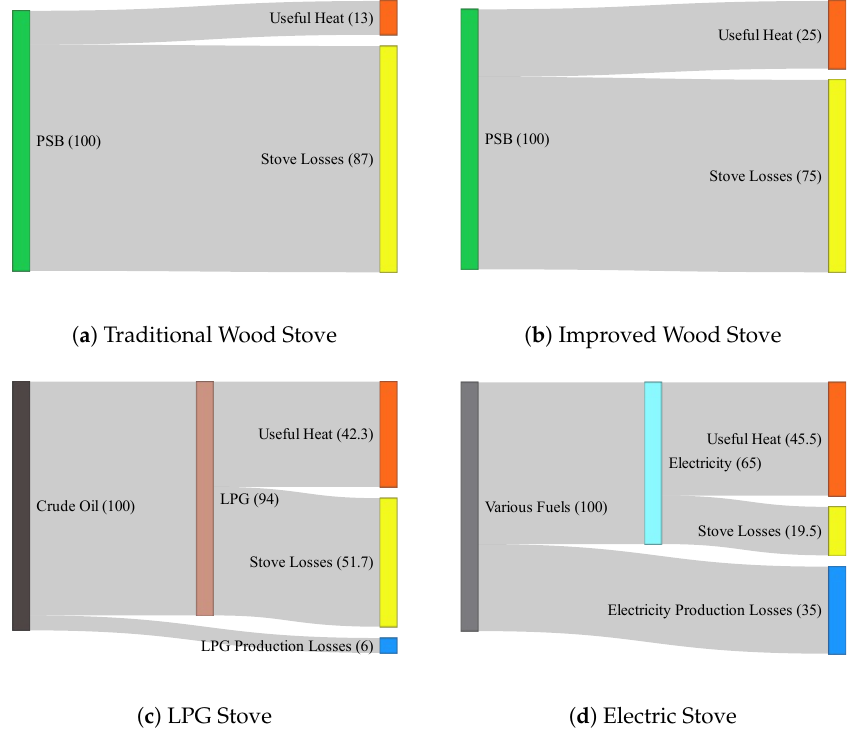
Figure 4. Sankey Diagram for a traditional wood stove and three higher efficiency alternatives. ( a ) shows the efficiency of heat production from a traditional wood stove common in Honduras, while ( b – d ) show the efficiency of improved wood stoves (e.g., Ecofogones), LPG stoves, and Electric stoves,